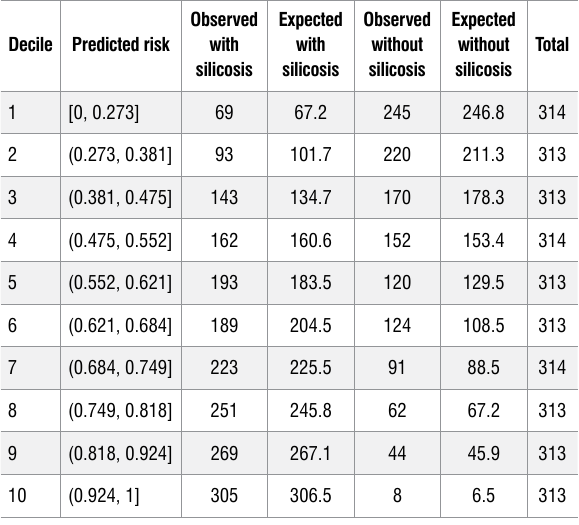
Comparison of observed and expected (under M3) counts with and without silicosis by predicted risk deciles Observed Decile Predicted risk with